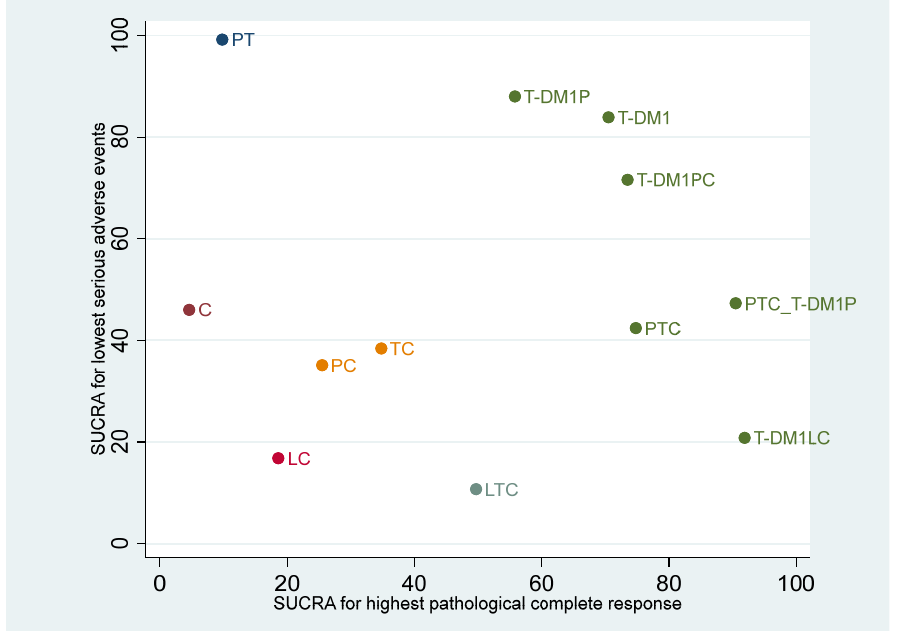
Figure 3. Clustered ranking plot of surface under the cumulative ranking curves (SUCRAs) for lowest probability of serious adverse events versus SUCRAs for highest probability of pathological complete response outcomes. C = chemotherapy; TC = Trastuzumab + chemotherapy; PC = Pertuzumab + chemotherapy; LC = Lapatinib + chemotherapy; PTC = Pertuzumab + trastuzumab + chemotherapy; LTC = Lapatinib + trastuzumab +chemotherapy; PT = Pertuzumab + trastuzumab; T-DM1P = trastuzumab emtansine+ pertuzumab; T-DM1LC = trastuzumab emtansine + lapatinib + chemotherapy; T-DM1PC = trastuzumab emtansine + pertuzumab + chemotherapy; PTC_T-DM1P = pertuzumab + trastuzumab + chemotherapy followed by trastuzumab emtansine + pertuzumab; T-DM1 = Trastuzumab emtansine.